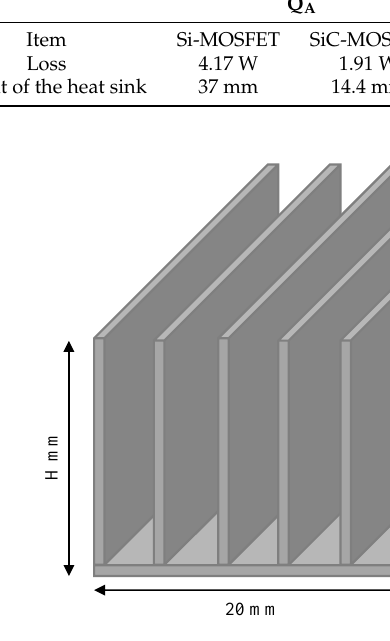
Figure 28. Outline drawing of the heat